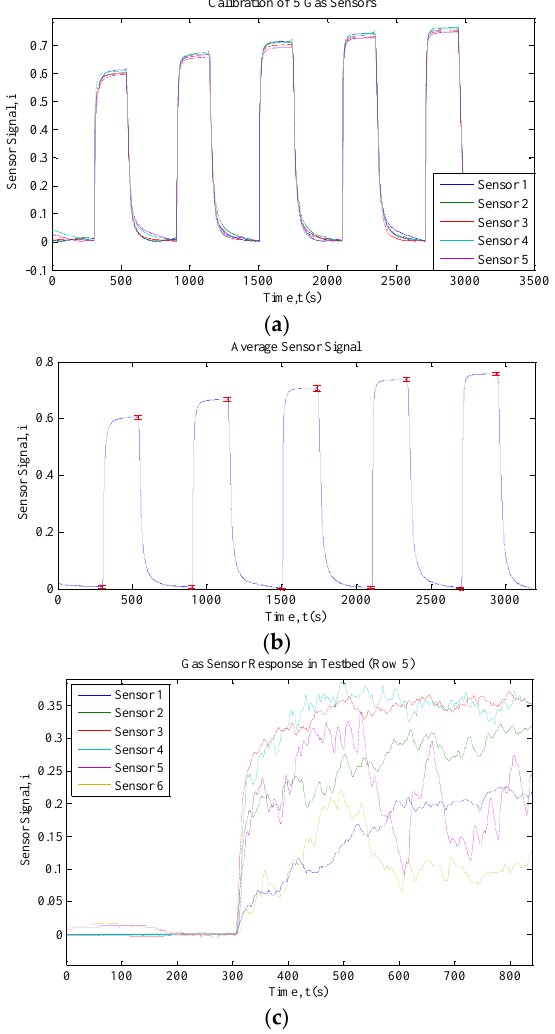
Figure 10. ( a ) Response of five gas sensors; ( b ) the average response; and ( c ) the response of gas sensors in the testbed.